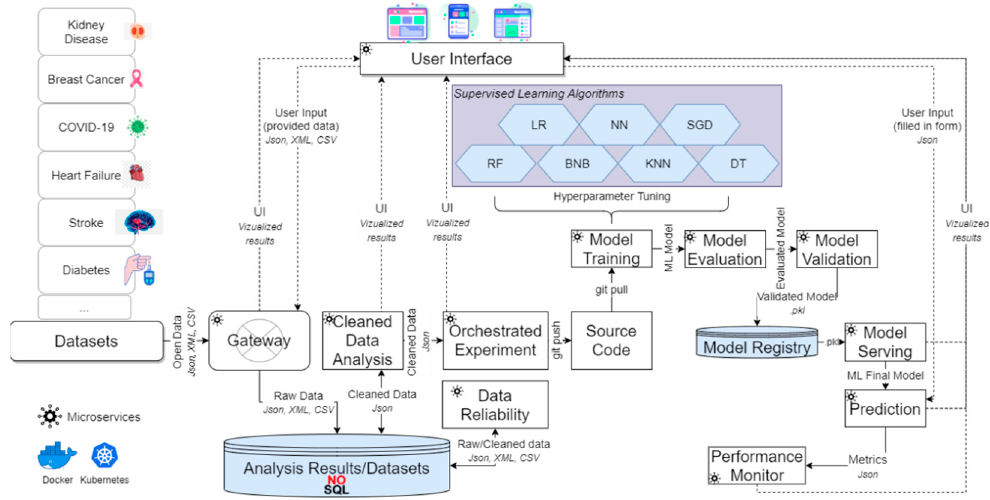
Figure 8. Overall mechanism architecture.